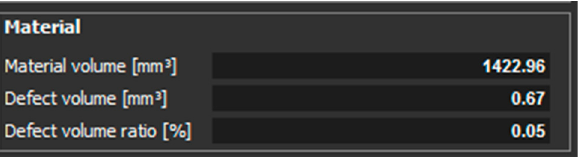
Figure 13. Measured values for a sample with 2 mm thickness, which is oriented in Z.